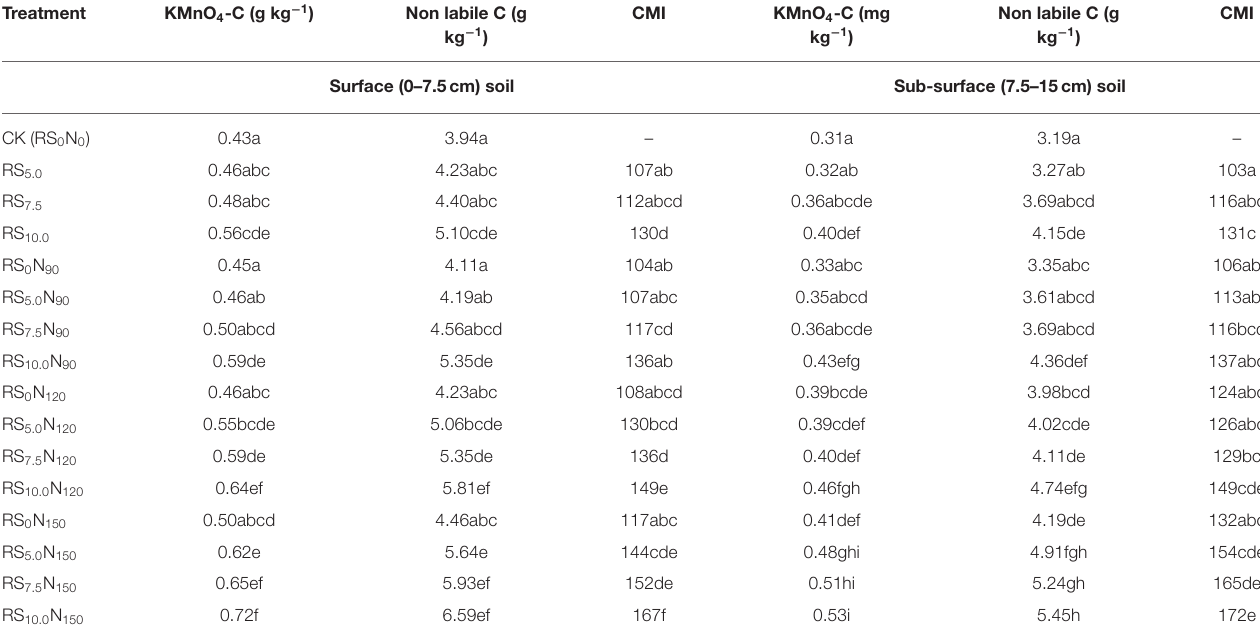
TABLE 6 | Effect of fertilizer-N application and rice straw (RS) incorporation on potassium permanganate oxidizable carbon (KMnO 4 -C), non-labile carbon and carbon management index (CMI) of surface (0–7.5cm) and sub-surface (7.5–15cm) soil depth under rice-wheat cropping system in north-western India. Treatment